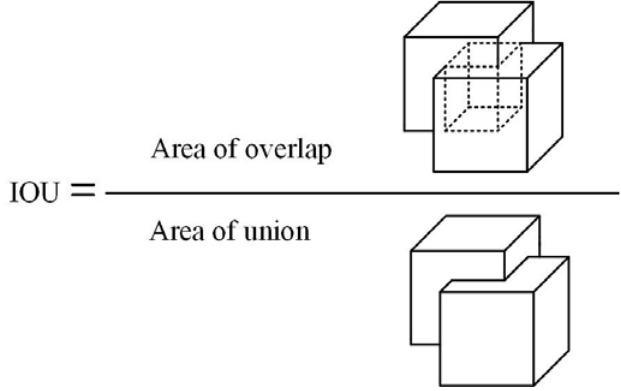
Figure 5. Three-dimensional IOU schematic.